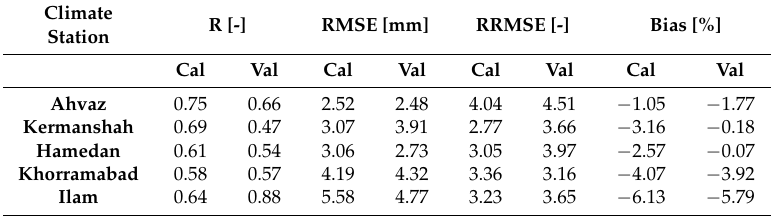
Table 4. Statistical performance measures of the SM2RAIN algorithm at the different climate